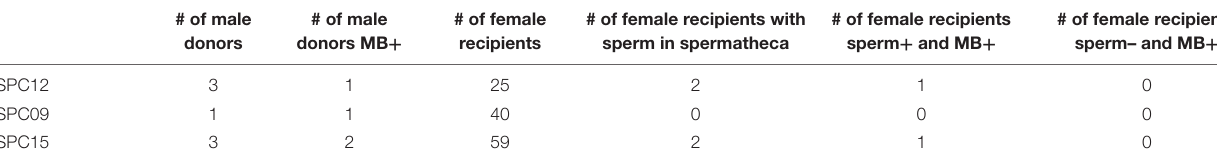
TABLE 5 | Microsporidia MB transmission is linked to the presence of sperm in female An. arabiensis spermatheca.